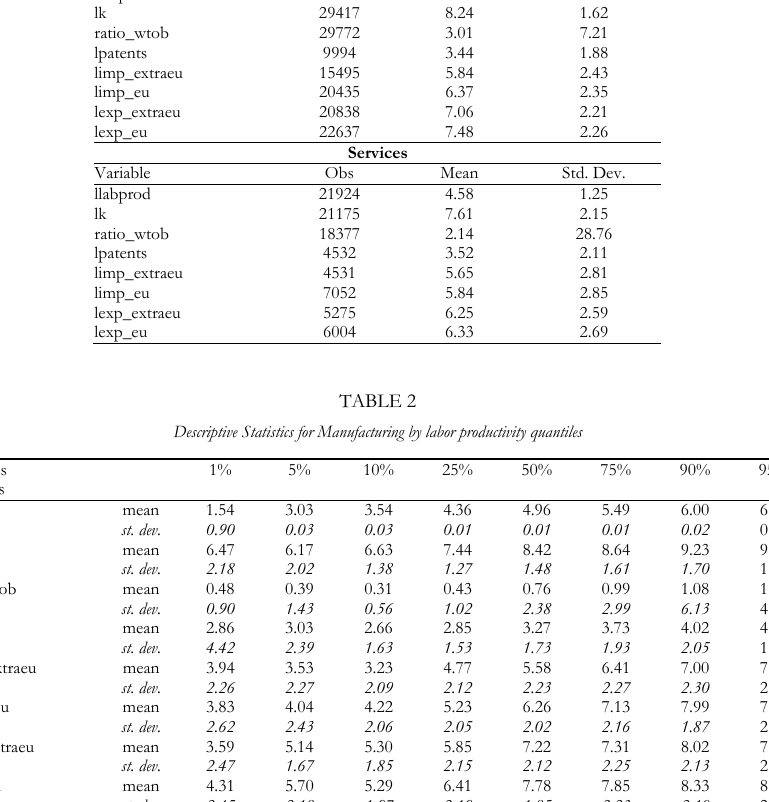
Descriptive Statistics for Manufacturing and Services Manufacturing Variable